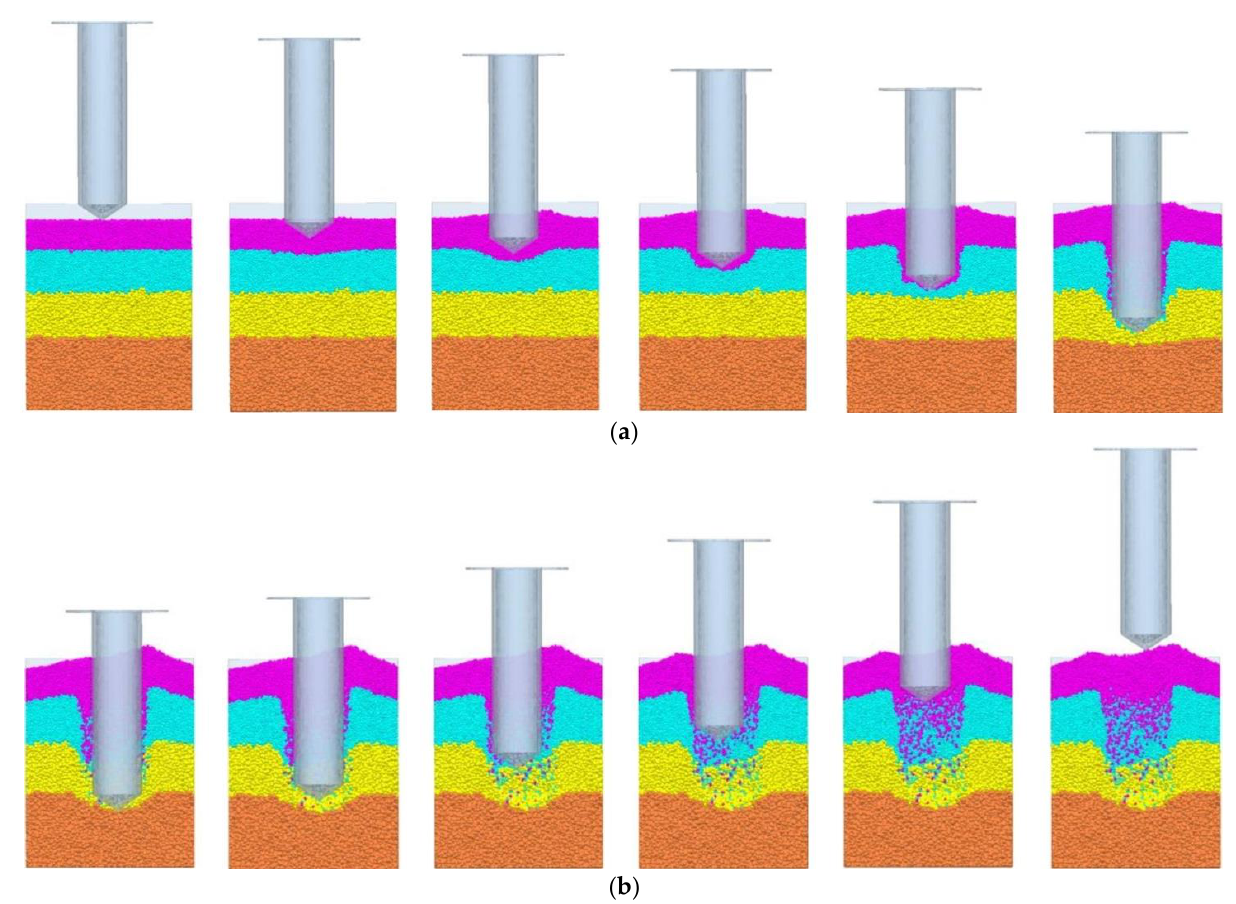
Figure 5. C avitating process of the cavitating mechanism: ( a ) process of the cavitator starting to interact with the soil driven by the cavitating mechanism until reaching the maximum depth of the cavitation; ( b ) process of the cavitator extracting from the cavitation driven by the cavitating mechanism after the cavitator reached the maximum cavitating depth.